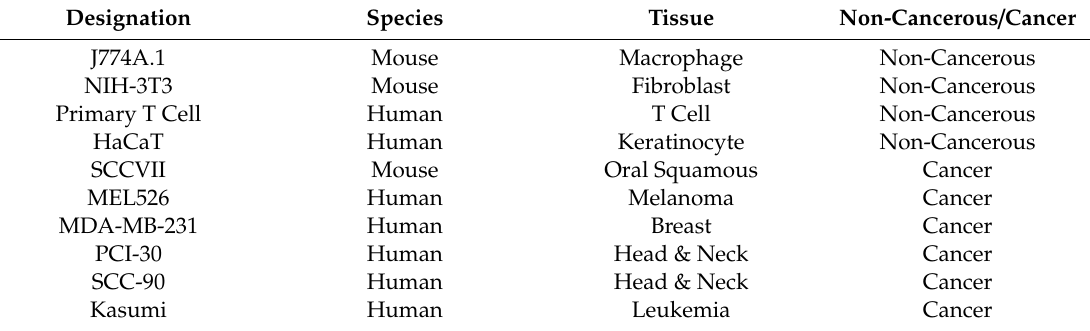
Table 1. Sources of Exosomes and Characteristics of Producer Cell Lines a